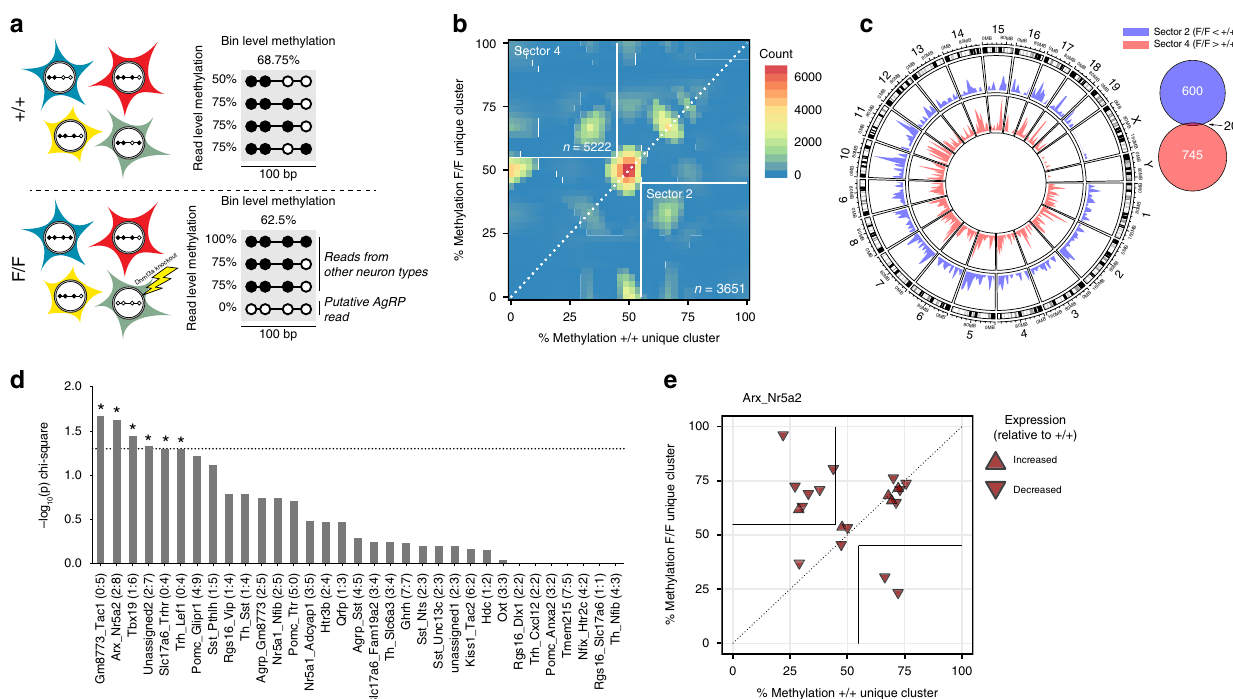
Fig. 4 Read-level analysis of WGBS data points to epigenetic dysregulation in cell type-speci fi c genes. a Illustration of strategy for pinpointing cell type-speci fi c loss of methylation from read-level WGBS data. Searching for differentially methylated read clusters in 100bp genomic bins enables inferences about changes taking place in individual cell types. Clusters comprise least 4 reads (see Methods); single reads are shown here for simplicity. Hypomethylated read clusters speci fi c to F/F mice likely originate from AgRP neurons, whereas substantially methylated read clusters speci fi c to F/F mice may arise from secondary effects in other cell types. b For each bin with both a cluster unique to F/F and a cluster unique to + / + mice, average methylation levels of the unique clusters are shown in a density plot. Bins in ‘ sector 2 ’ are de fi ned by the simultaneous absence of a substantially methylated ( ≥ 55%) read cluster in + / + mice and appearance of a novel hypomethylated ( ≤ 45%) read cluster in + / + mice. ‘ Sector 4 ’ is de fi ned conversely. c Circos plot showing density of sectors 2 and 4 bins located in promoter regions of genes. Right: Venn diagram shows minimal overlap of sectors 2 and 4 promoter bins. d Promoter bins for differentially expressed genes speci fi c to the molecularly de fi ned ARH neural cell types Gm8773/Tac1, Arx/Nr5a2, Tbx19, unassigned2, Slc17a6/Trhr , and Trh/Lef1 25 are enriched in sector 4 relative to sector 2, suggesting that these cell types contribute to the observed hypermethylation in F/F ARH neurons as a whole. Bars represent − log 10 ( p ) of χ 2 tests comparing cell type-speci fi c sectors 2 and 4 bins relative to a background list of all sectors 2 and 4 bins (* p <0.05). Numbers in parentheses represent ratio of sector 2:sector 4 bin counts. e Plot showing the location of promoter bins for differentially expressed genes speci fi c to Arx/Nr5a2 ARH neurons. Plot coordinates follow the same convention as b